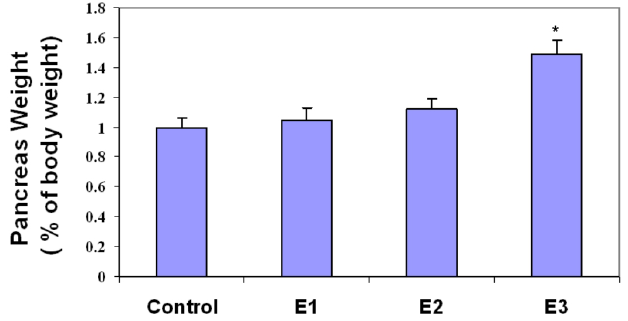
FIGURE 3- Relative pancreas weight / body weight in control and experimental groups. Values expressed as means ± SD for 8 mice. * P < 0.05 compared to control